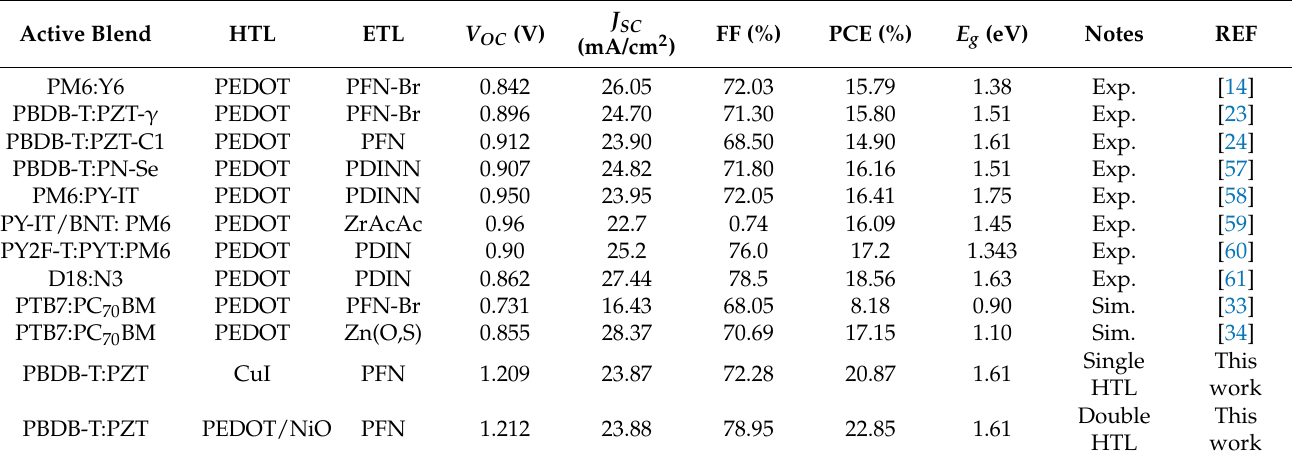
Table 5. State-of-the-art comparison between some experimental and simulated polymer-based SCs, showing the main PV performance parameters.